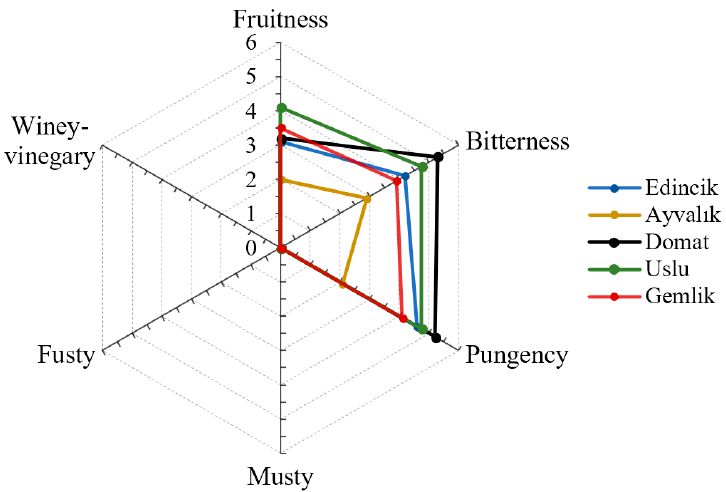
Figure 3. Scores of sensory attributes of EVOOs from five Turkish olive cultivars.